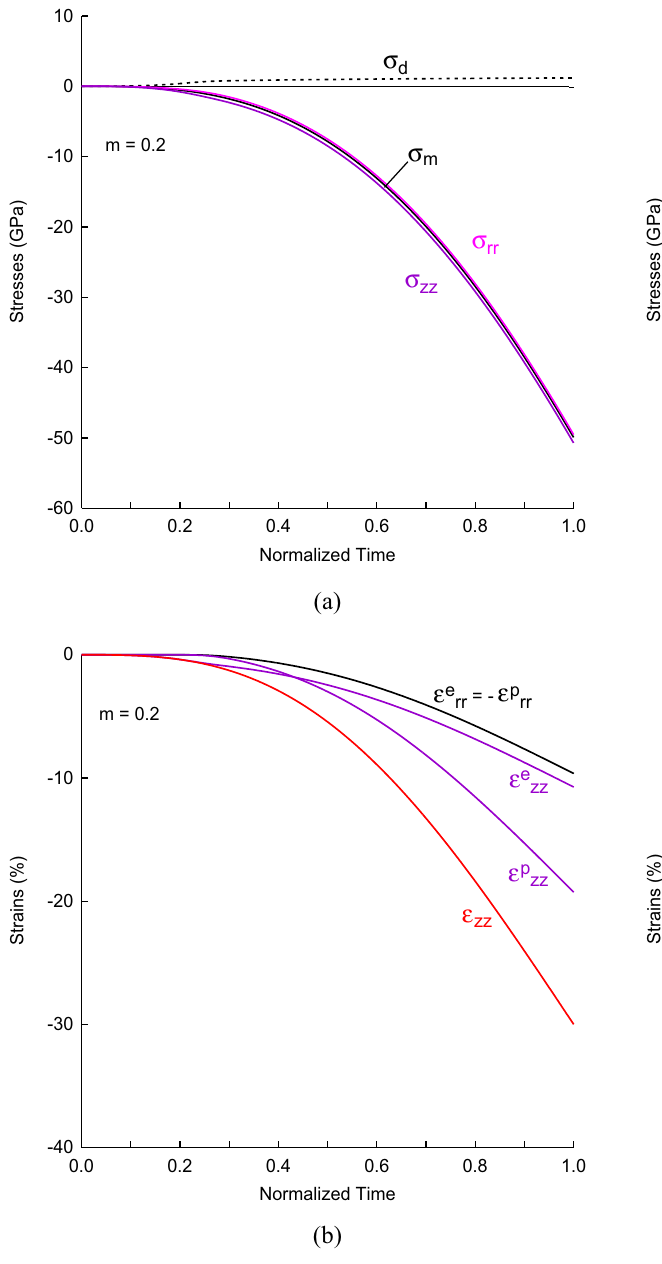
Fig. 4. Time dependence of the stresses (a) and the elastic, plastic, and total strains (b) of a nonlinear (m = 0 . 2) elastic-viscoplastic material.